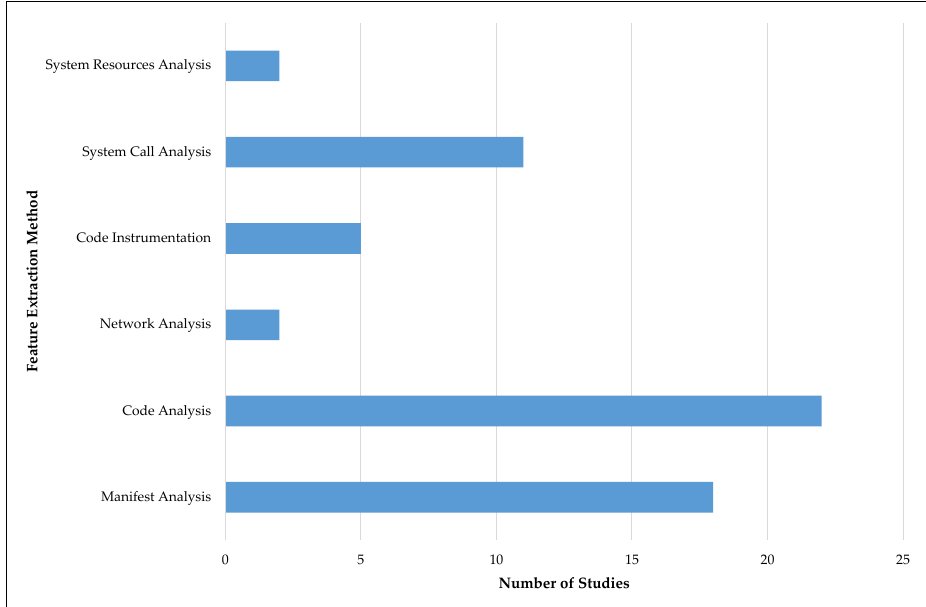
Figure 4. Feature extraction methods used in the reviewed studies.